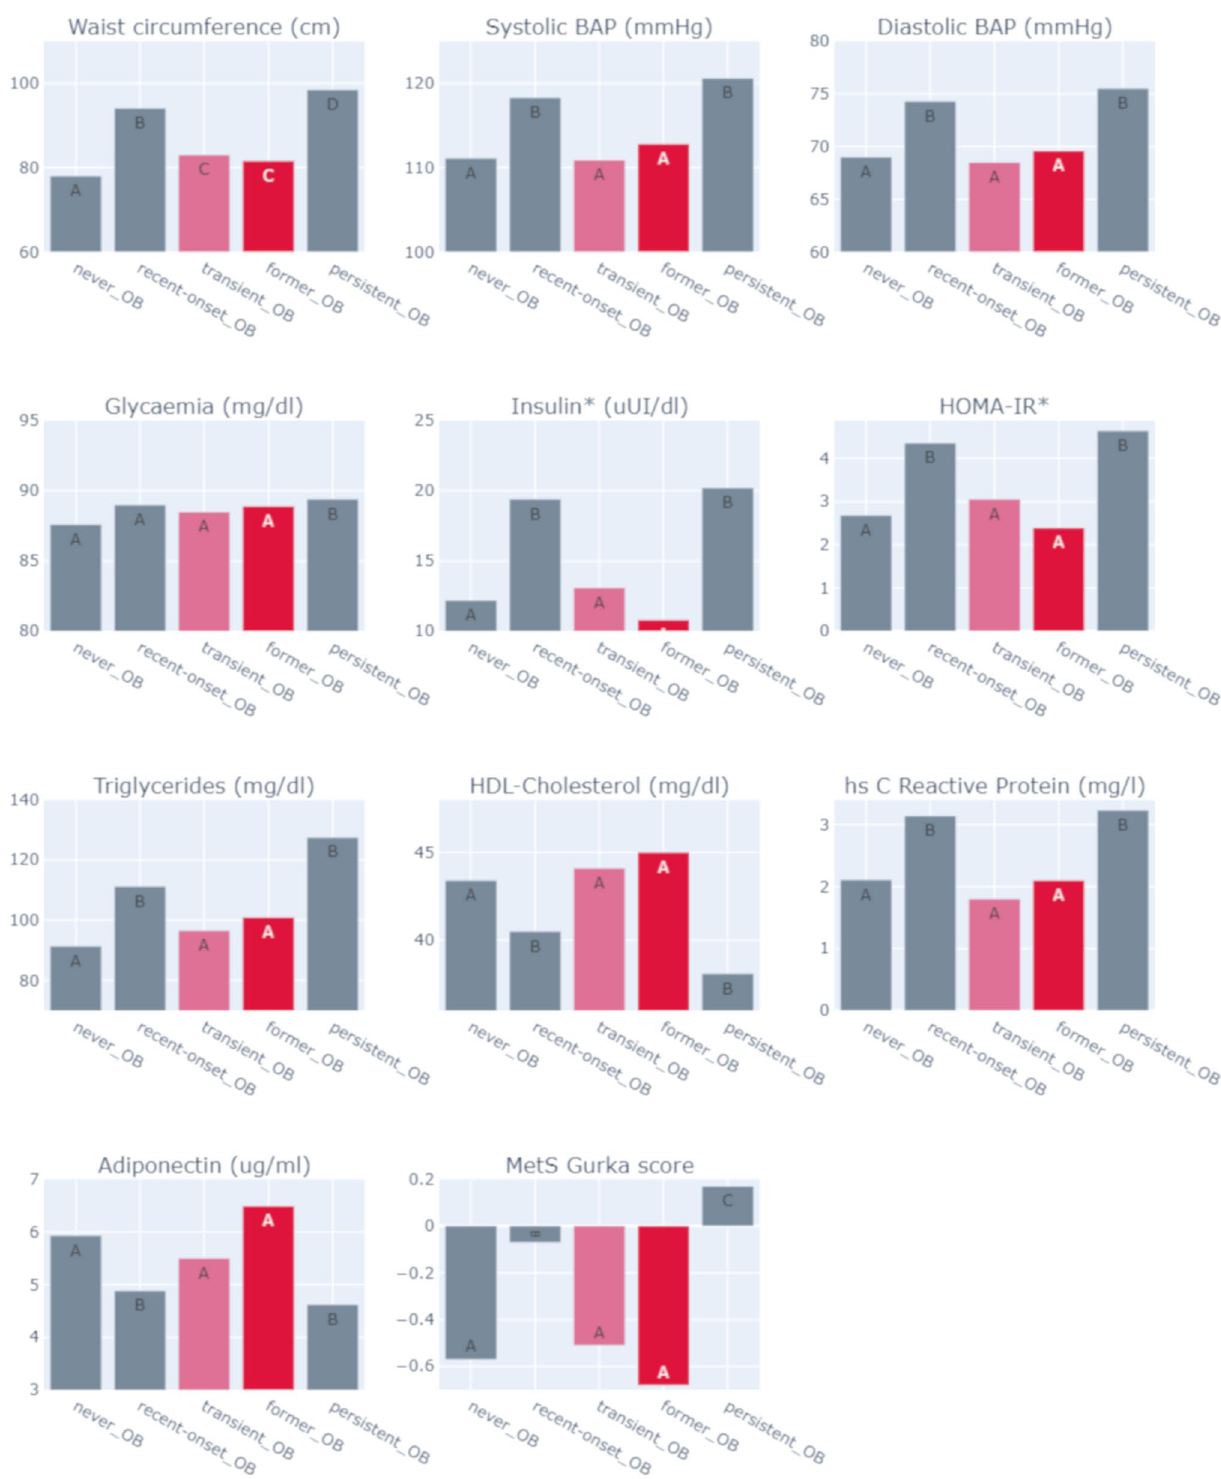
Figure 3. Association of age of onset and persistency of obesity with cardiometabolic profile in adulthood (23 years): ‘Post-hoc’ analysis (n = 1039). Participants who were never obese (never-OBs, A); participants with obesity starting in adolescence and remained obese into adulthood (recent-onset-OBs, B); participants who were obese in early childhood but transitioned to non-obesity as preadolescents (former-OBs, C); participants who were obese in early childhood and remained obese into adulthood (persistent-OBs, D); and participants with obesity starting in preadolescence and transitioned to non-obesity as adolescents (transient-OBs, E). Models were adjusted for sex and having insulin resistance at 23 years (HOMA-IR ≥ 2.6), except as indicated. *Models were adjusted for sex and having the Metabolic Syndrome at 23 years. Participants having hs-CRP values ≥ 9 mg/dl were excluded from the analysis (n = 171). Post hoc analysis: Letters (A–E) within a bar indicate significant differences between obesity-status categories according to Bonferroni’s